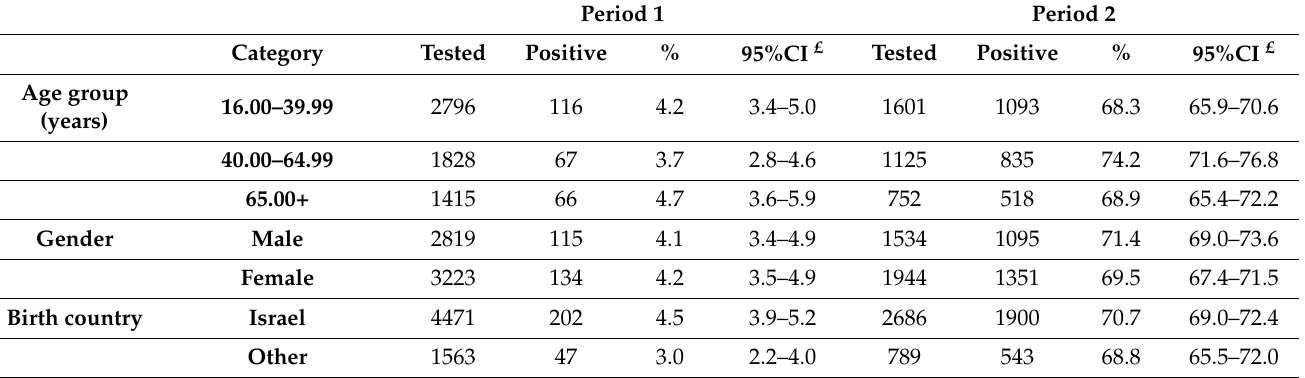
Table 2. SARS-CoV-2 seropositivity by demographic characteristics and time periods (period 1 =